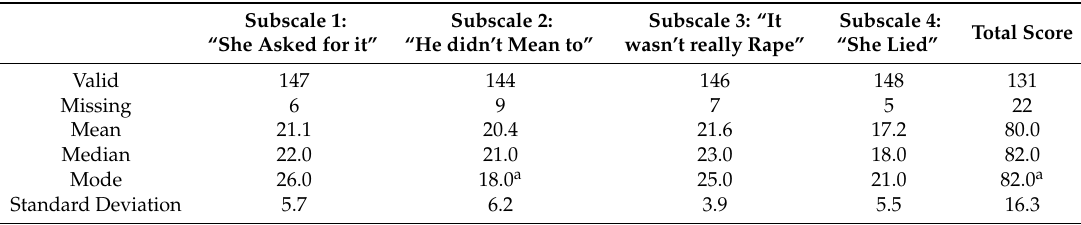
Table 1. Updated Illinois Rape Myth Acceptance Scale (IRMA) Sub-Scales and Total Scores. Subscale 1: “She Asked for it”